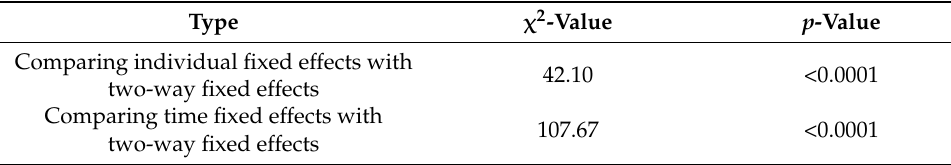
Table 7. Test analysis for optimal effect